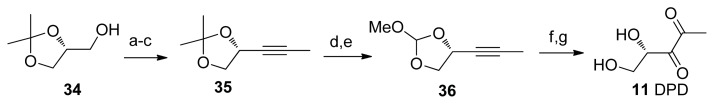
First reported synthesis of DPD and analogs. Reagents and conditions: (a) Oxayl chloride, DMSO, CH2Cl2; Et3N; (b) Zn, CBr4, Ph3P, CH2Cl2; (c) t-BuLi, CH3I, THF; (d) 60% acetic acid; (e) CH(OMe)3 (neat), H2SO4 (cat); (f) KMnO4, acetone buffer (aq); (g) H2O, pH 6.5 (K2HPO4/KH2PO4 (0.1 M), NaCl (0.15 M)), 24 h.